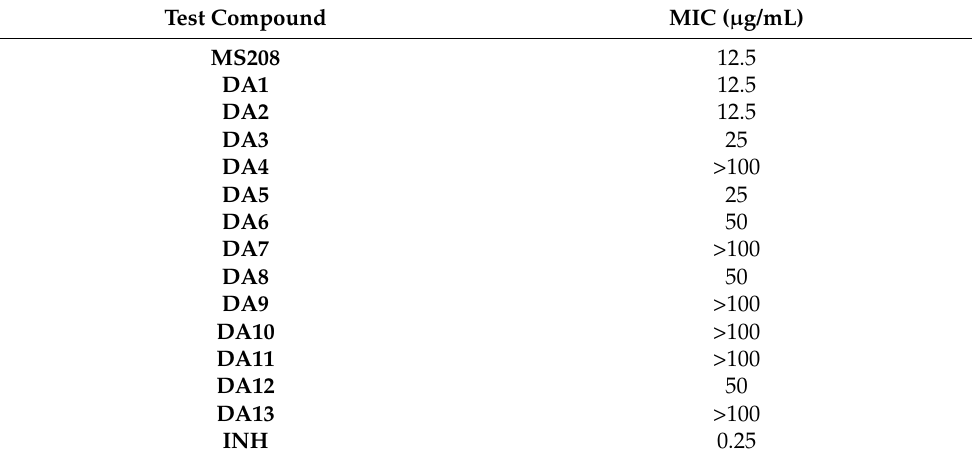
Table 1. MICs of the synthesized compounds as determined by REMA. Isoniazid (INH) was used a positive control. Test